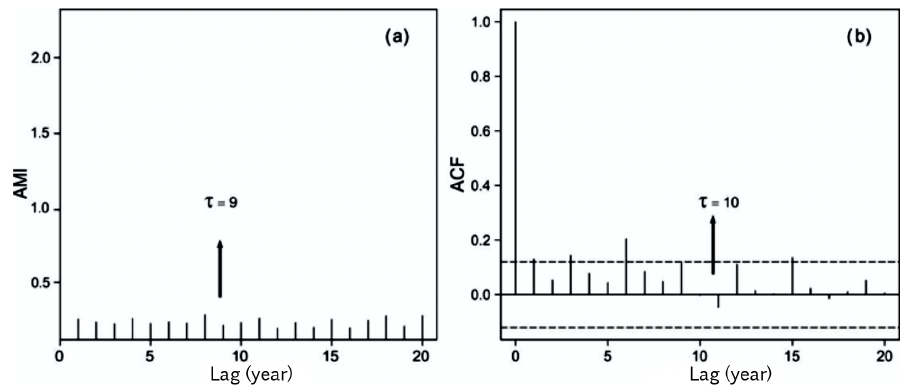
Figure 3. The mutual information method (a) : the x axis indicates the time lag against the mutual information index (AMI) and the arrow indicates the first, most pronounced minimum with a value of τ = 9. The autocorrelation function (b) , the x axis indicates the time lag versus the value of the autocorrelation function, and the arrow denotes where the first zero of the function τ = 10 was obtained.